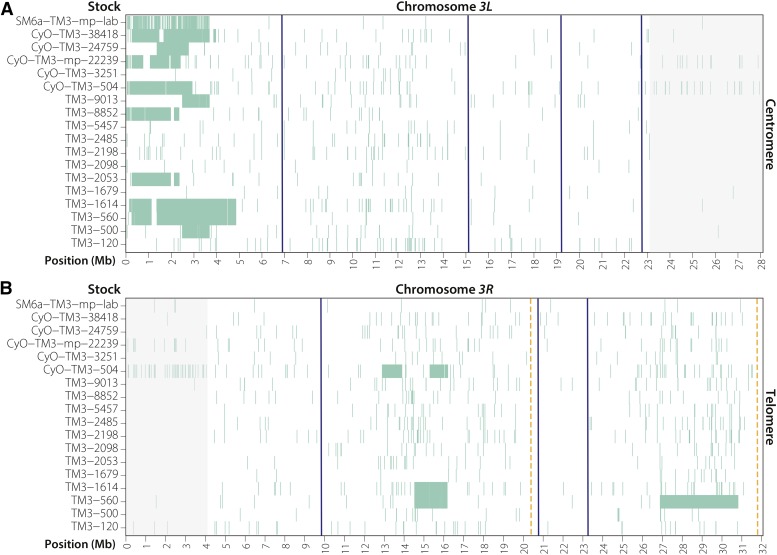
Visualizing SNPs present in five or fewer TM3 chromosomes reveals numerous single crossover events on 3L and several DCO events on 3R (see Materials and Methods). Blue lines indicate the positions of inversion breakpoints whose precise location is known, orange dashed lines show the approximate positions of the unidentified In(3R)C (92D1-E1;100F2-3) inversion breakpoints. Gray shaded regions are centromere-proximal heterochromatin with low-quality read alignment. (A) Single crossovers are common in the region distal to the 65D inversion breakpoint at position 3L:6,925,034, and occur no closer than 2 Mb from the breakpoint. (B) Several DCOs are apparent on 3R. Stocks TM3-560 and TM3-1614 may be versions of TM3 before Ser1 was added to a TM3, Sb+ Ser+ chromosome (TM3-560), and before Sb1 was added to a TM3, Sb+ Ser1 chromosome (TM3-1614).